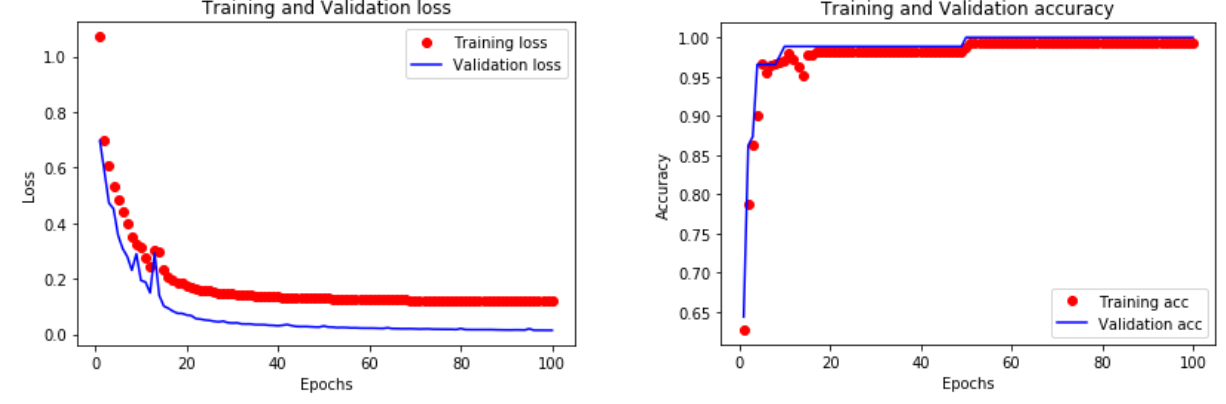
Figure 9. The relationship diagram of loss and accuracy with iteration times.